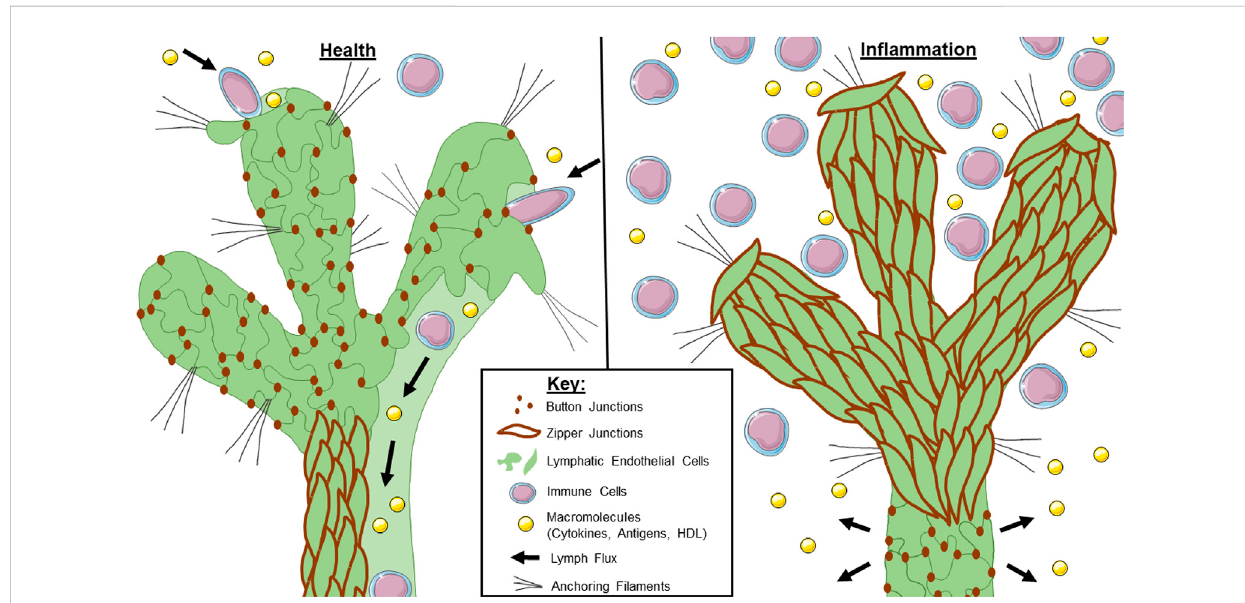
FIGURE 1 Lymphatic junctional morphology during health and in fl ammation. In a healthy lymphatic vessel (left), the initial lymphatics are lined with button junctions. As interstitial pressure increases, the anchoring fi laments expand with the extracellular matrix which facilitates lymph entry through the gaps between buttons. Lymph is maintained within the lymphatic system by virtue of the zipper junctions in the collecting lymphatics. During in fl ammation (right), initial lymphatics undergo a button-to-zipper transformation which may prevent lymph uptake. Less is known about the junctional morphologyofcollectinglymphaticsduring in fl ammation, butsomestudiessuggestzipper-to-button transformationwhichwouldcauseleakageofany lymph that makes it into the system. Overall, this contributes to poor lymphatic fl ux during in fl